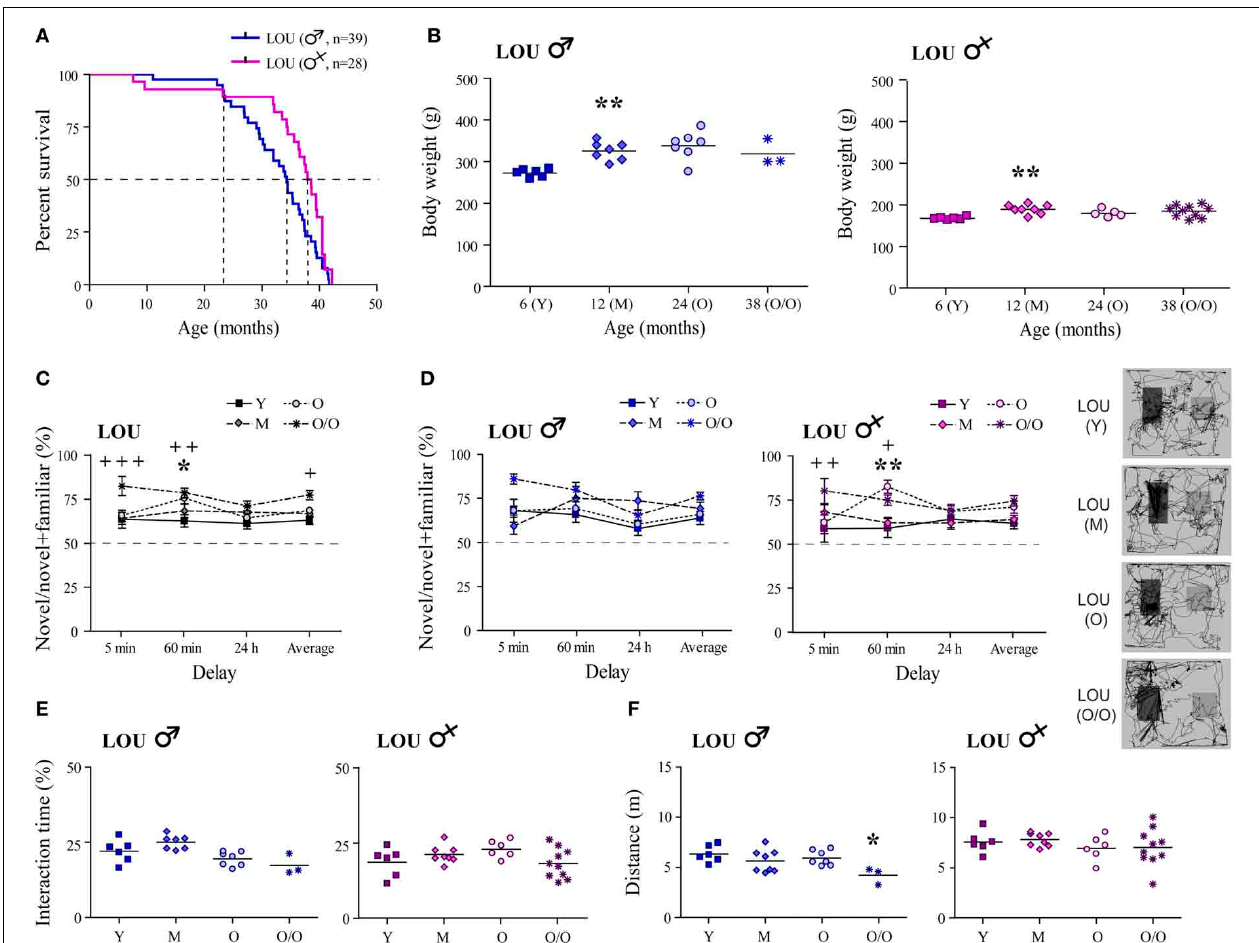
FIGURE 1 | Male and female LOU rats are characterized by high longevity, stablebodyweight,andintactrecognitionmemory.(A) Mediansurvivalage was 38.2 months for females vs. 34.3 months for males LOU rats. (B) BW of maleandfemaleLOUratsincreasedonlyslightlyinthecourseofaging(Y,young adult; M, mature; O, old; O/O, old/old). (C) Amount of time spent interacting with novel objects did not decrease with age in LOU rats, and O/O rats spent significantly more time with novel objects on average and after the 5- and 60-min delay than young rats. (D) Recognition memory is intact in males and